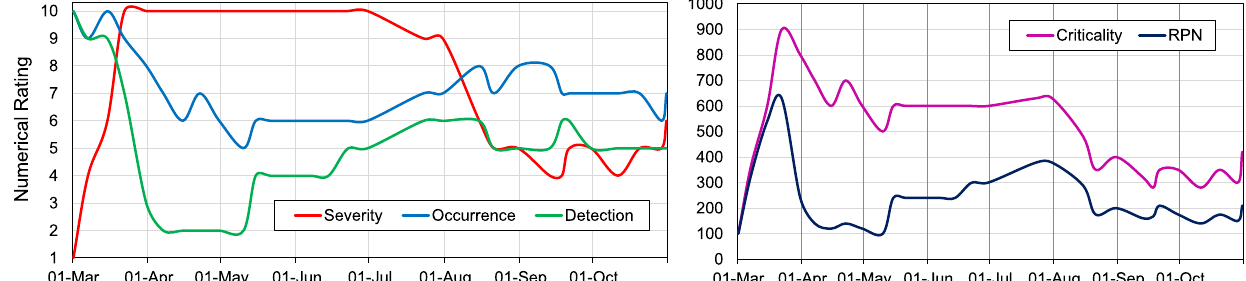
Fig. 9. A visual summary of a 10-point FMEA rating (left) and the criticality/RPN (right). Results re fl ect the United Kingdom COVID-19 pandemic by following the timeline on Table 3 and the evaluation criteria on